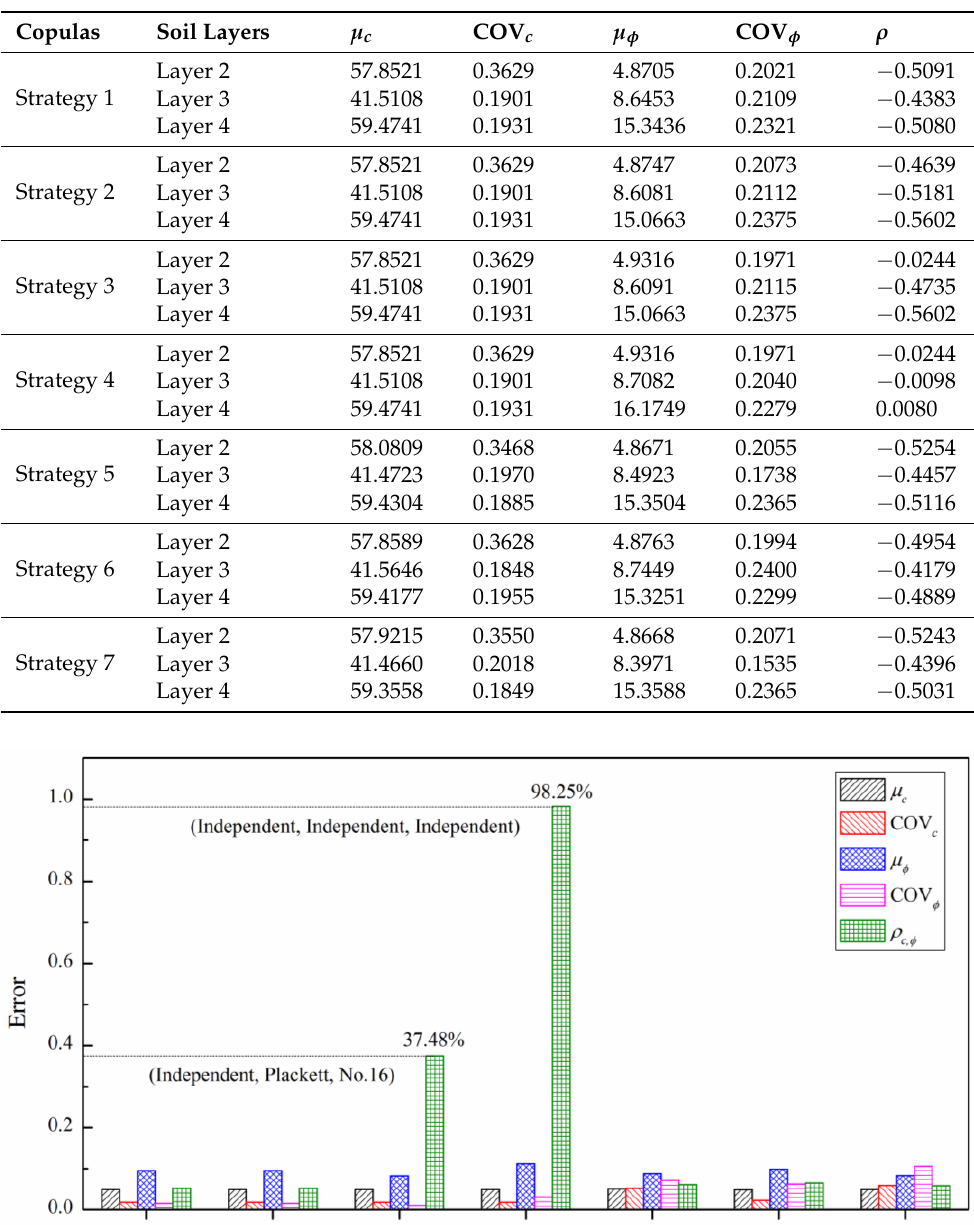
Table 8. Statistics of CCRF variables associated with different strategies.